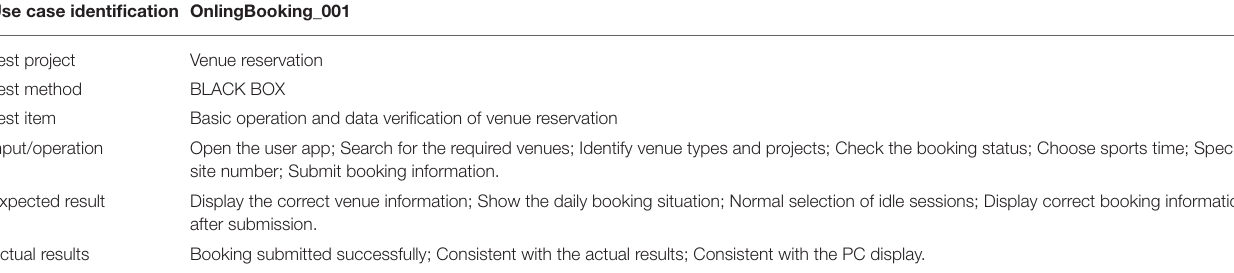
TABLE 1 | Booking system functional